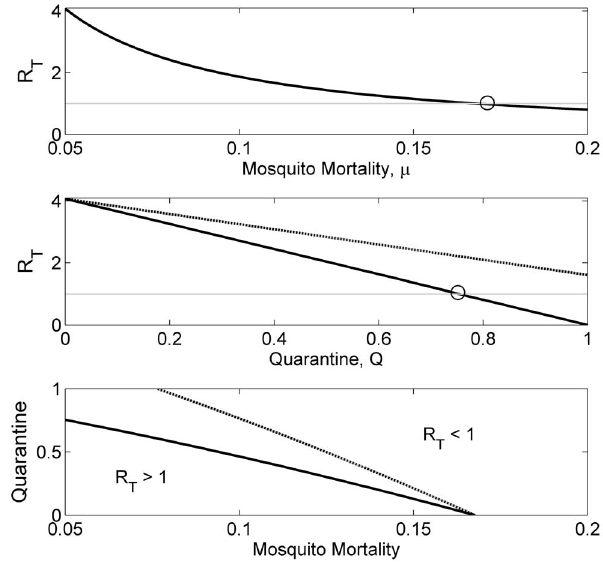
Figure 4. Controlling a chikungunya epidemic. Top, the reduction in the type reproduction number ( R T ) as a function of vector control (increased mosquito mortality rate). Middle, the reduction in the type reproduction number as a function of quarantine (solid line, Q 1 – pre- emptive isolation through screening or self-reporting mosquito bites, and, broken line, Q 2 – isolation following symptoms onset). Bottom, the combinations of vector control with quarantining (solid line Q 1 and broken line Q 2 ) required to reduce the R T below unity.